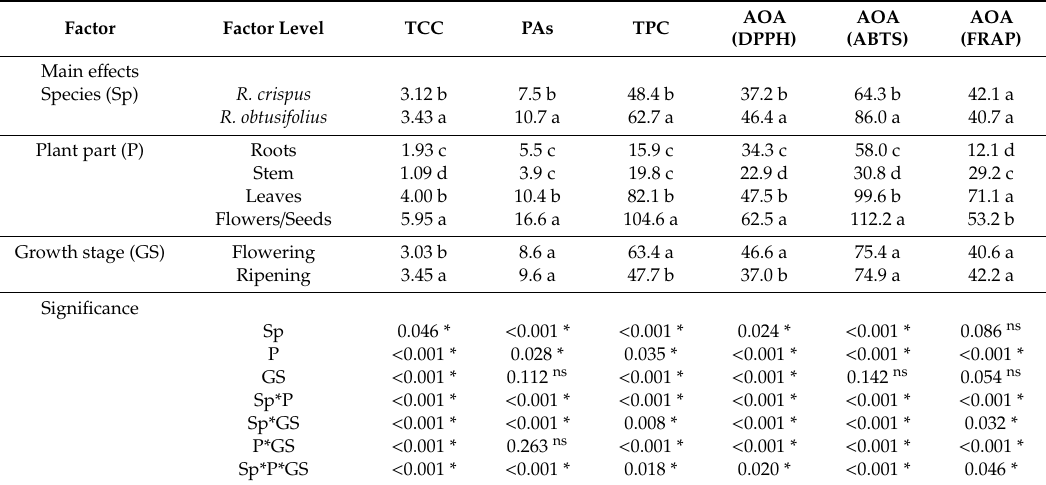
Table 1. Results of three-factorial analysis of variance (ANOVA) for phenolic compounds and antioxidant activity of sorrel extracts.